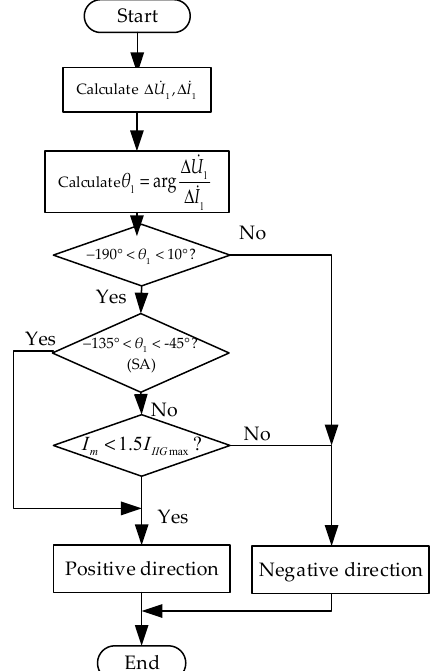
Figure 6. Flow chart of the improved directional relay.